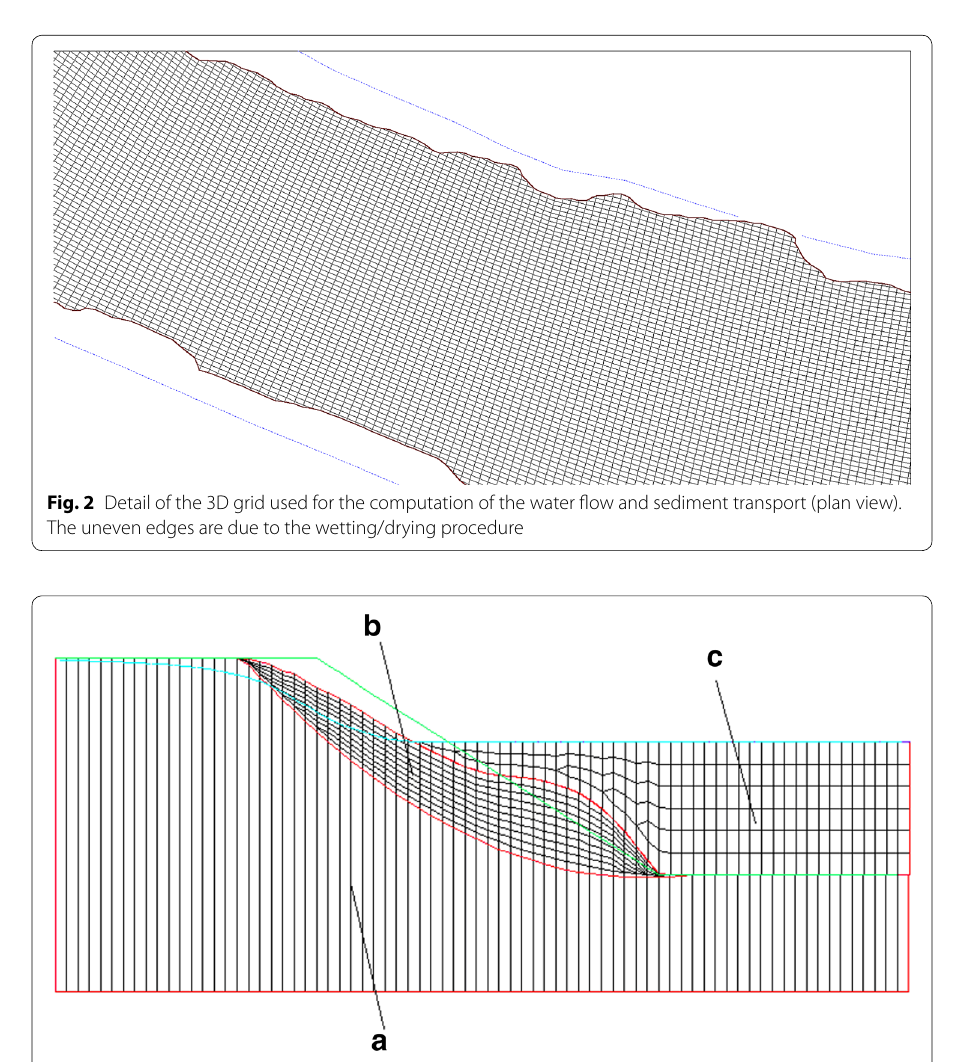
Fig. 3 Cross-sectional profile of a river bank with the three types of grids, used for the slide movement computation. The groundwater grid is given as a , b is the grid for the soil movement and c is the grid for the water/sediment flow. The light blue line is the water surface and the groundwater level. From Olsen